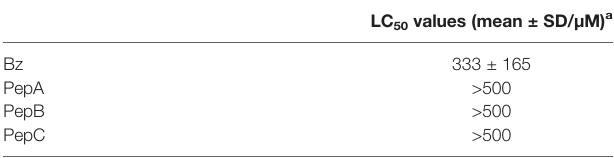
TABLE 1 | Determination of the cytotoxicity pro fi le (LC 50 values) of peptides (PepA, PepB, and PepC) and benznidazole (Bz) on the primary culture of peritoneal mouse macrophages